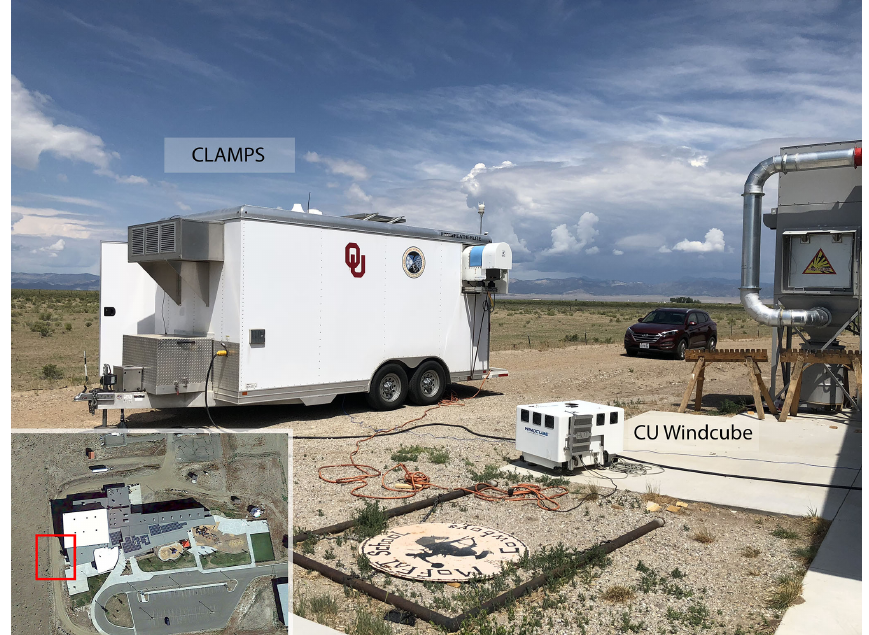
Figure 1. This photo shows the CLAMPS facility (white trailer) and the CU DPLR2 (foreground on the concrete pad) deployment location next to the Moffat Consolidated School. The red box on the satellite view shows where CLAMPS and DPLR2 were deployed in relation to the school building. Note that due to the proximity of the CLAMPS trailer to the building, the wind speed and wind direction from the meteorological station on the back of CLAMPS should be used cautiously. Satellite imagery © Google